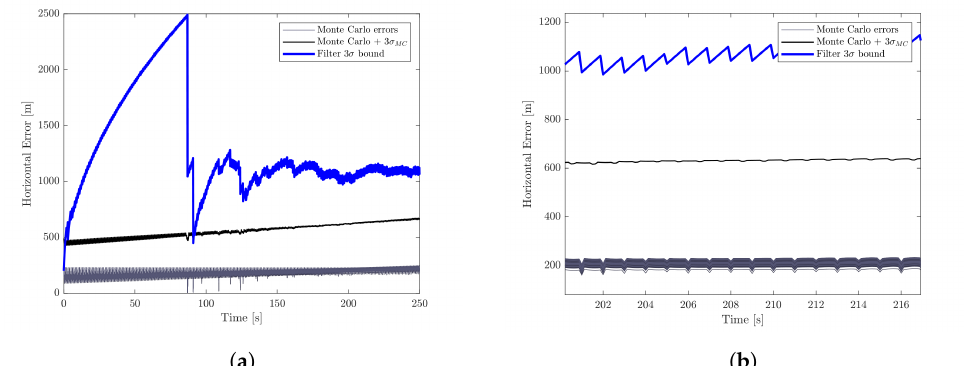
Figure 12. Monte Carlo runs for the landing trajectory. At each time step, the horizontal estimation error for each Monte Carlo sample is reported. The 3 σ bound derived from the filter covariance esti- mation is compared with the 3 σ bound at each time step of the Monte Carlo population. ( a ) Horizontal error—Monte Carlo runs. ( b ) Horizontal error—Monte Carlo runs: zoom.